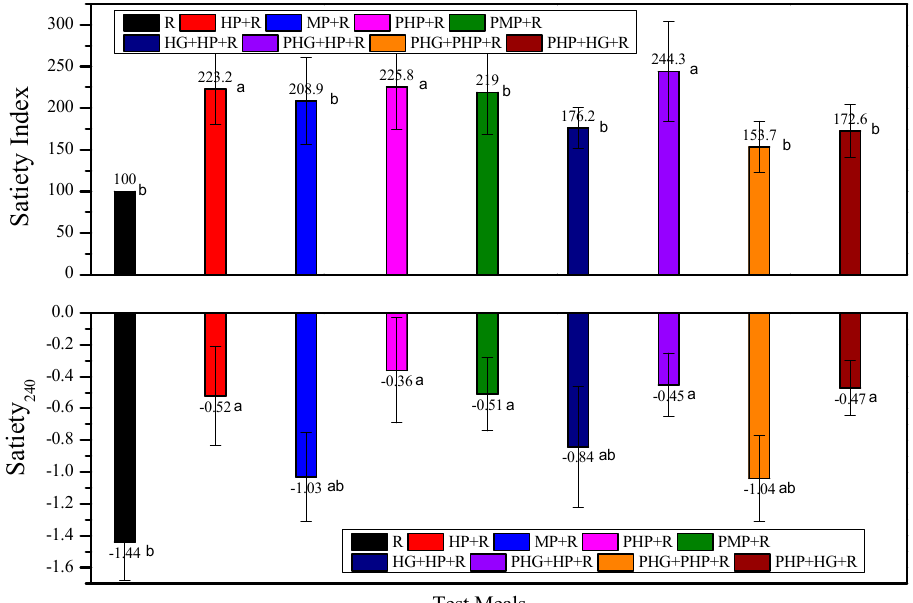
Figure 5. Satiety index and satiety at 240 min for test foods. R, rice; HP, highly cooked potato; PHP, preload highly cooked potato; MP, minimally cooked potato; PMP, preload minimally cooked potato; HP + R, co-ingestion of HP and rice; MP + R, co-ingestion of MP and rice; PHP + R, preload HP prior to rice meal; PMP + R, preload MP prior to rice meal; HG, partially hydrolyzed guar gum; PHG, preload HG; HG + HP + R, co-ingestion of HG, HP and rice; PHG + HP + R, preload HG prior to co-ingestion of HP and rice; PHG + PHP + R, co-preload of HG and HP prior to rice meal; PHP + HG + R, preload of HP prior to co-ingestion of HG and rice. Values are shown as the mean value with their standard errors represented by vertical bars. Data were analyzed by one-way (treatment) ANOVA with Duncan’s multiple range test, significant di ff erences ( p < 0.05) were represented by di ff erent letters and values are shown as the mean value with their standard errors represented by vertical bars.